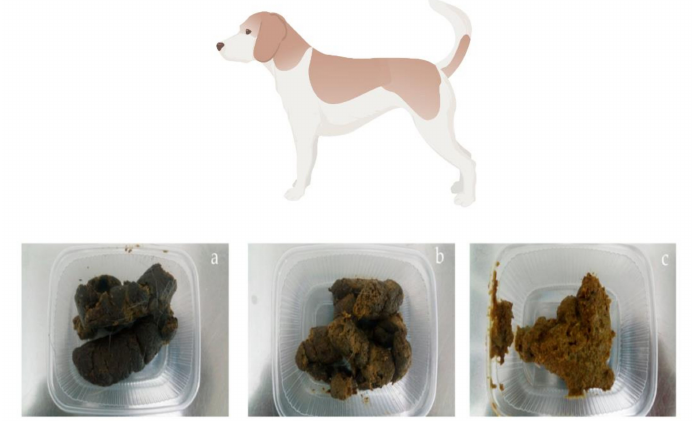
Figure 1. Fecal scores in accordance with Moxham [43] study: a = score 2 (solid, well formed); b = score 3 (soft, still formed); c = score 4 (pasty, slushy); Photo: Abd El-Wahab, A. © TiHo (figure was created with BioRender.com on 22 May